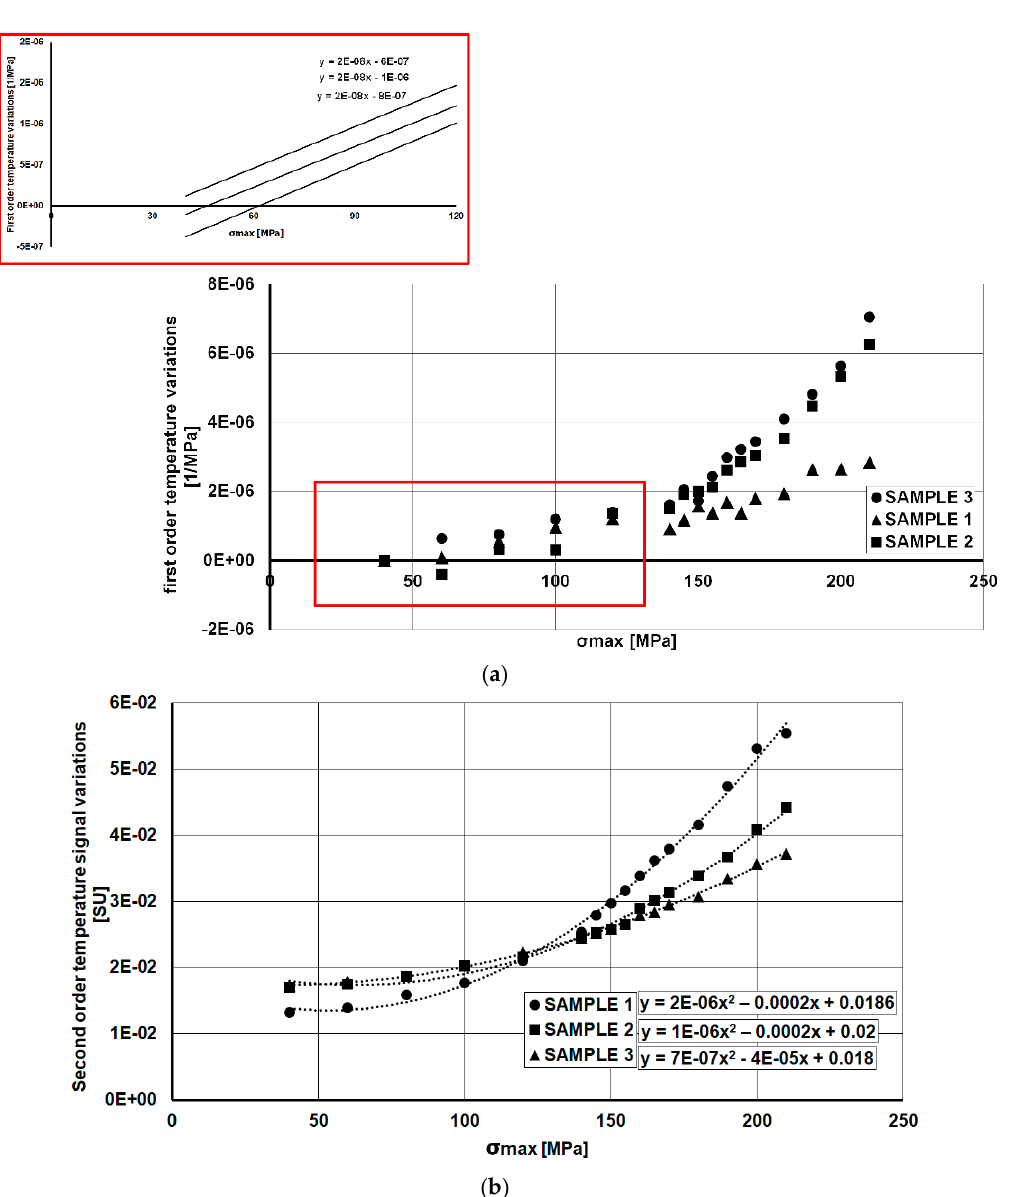
Figure 8. Rough data of the thermal signal components: S 1 ( a ) S 2 ( b ).